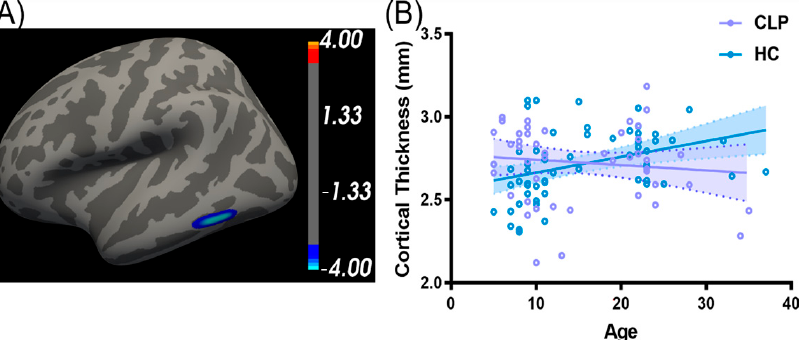
Figure 4. Cortical thickness of the left inferior temporal cortex exhibited a significant “group × age” interaction e ff ect. ( A ) Signi fi cant interaction e ff ect of “group × age” in the left inferior temporal cortex; ( B ) age slopes of regional mean cortical thickness in the left inferior temporal cortex in CLP and HC. Gender was regressed out as a covariate, and signi fi cance was set at cluster-wise p < 0.05 using Monte Carlo simulation with 5000 iterations.